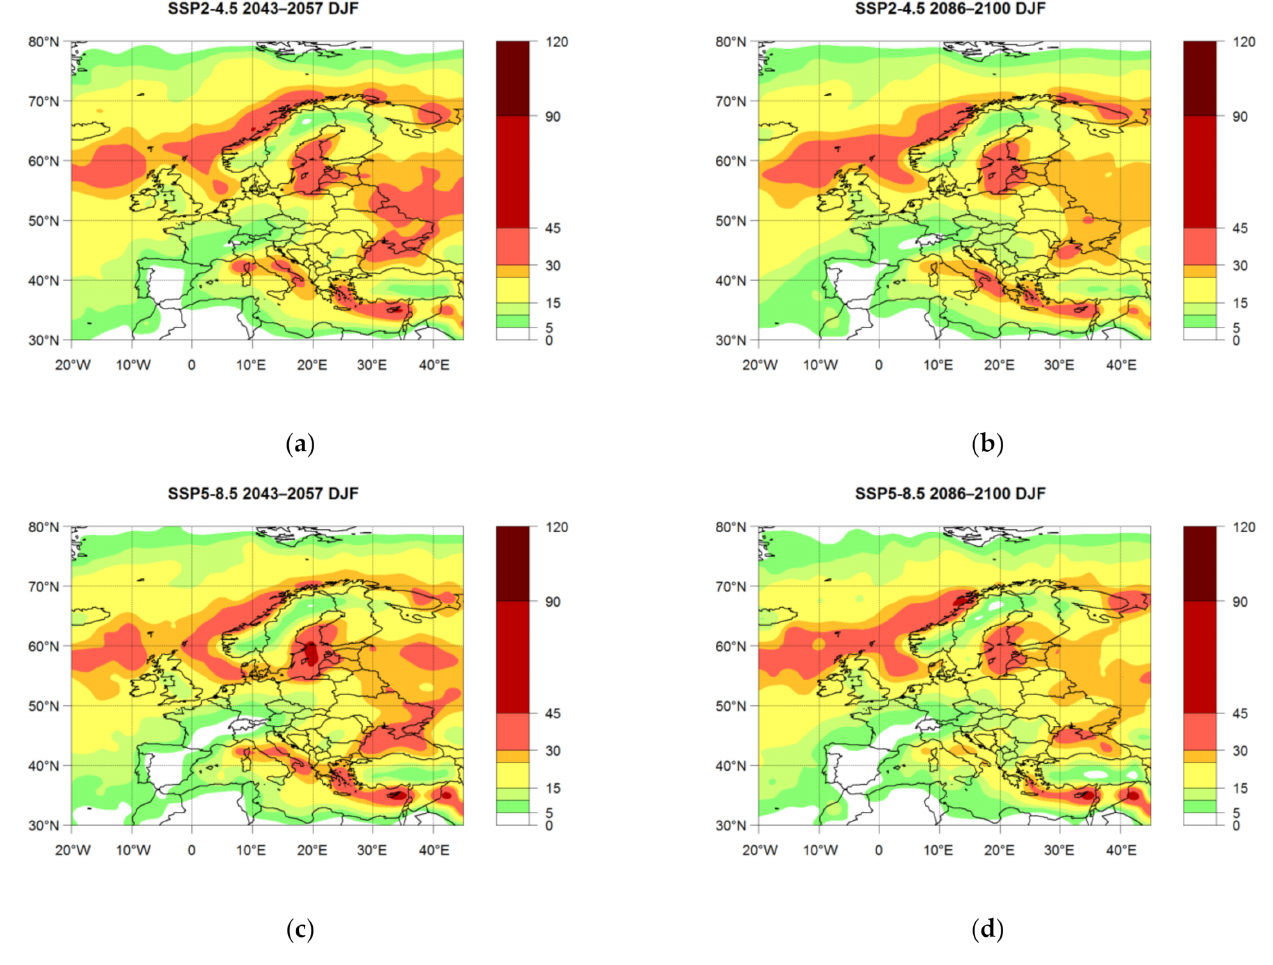
Figure 3. Frequency (total number for 15 seasons) of winter cyclones in the ensemble of the CMIP6 models: ( a , c ) at the middle of the 21st century; ( b , d ) at the end of the 21st century; ( a , b ) under the SSP2-4.5 scenario; and ( c , d ) under the SSP5-8.5